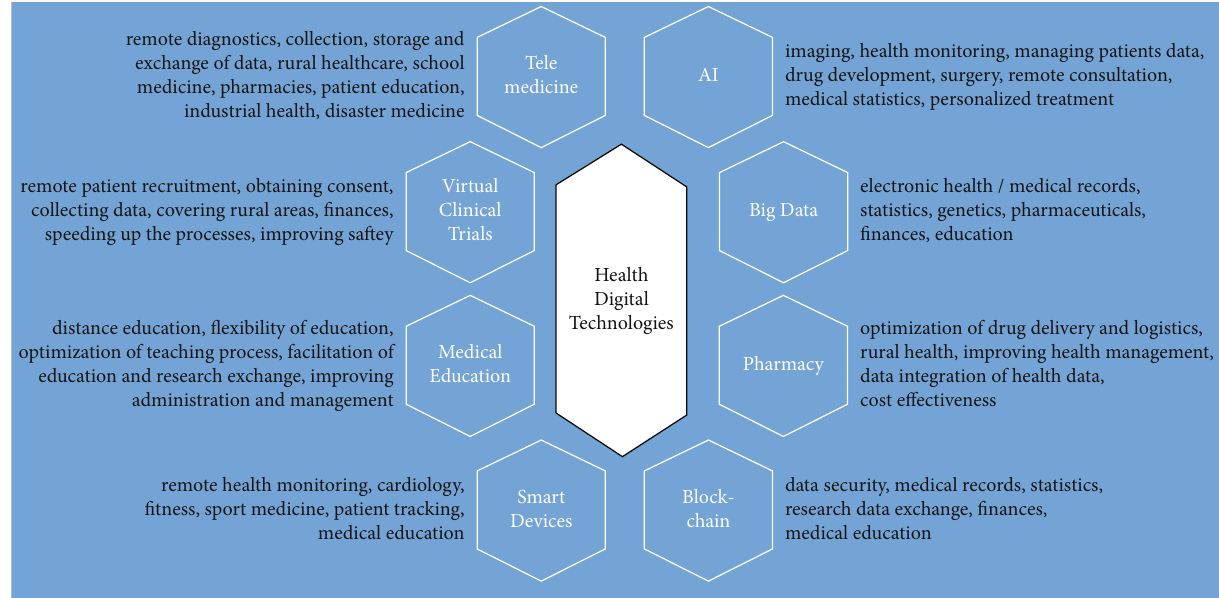
Figure 4: Summary of applications of digital health technologies discussed in the